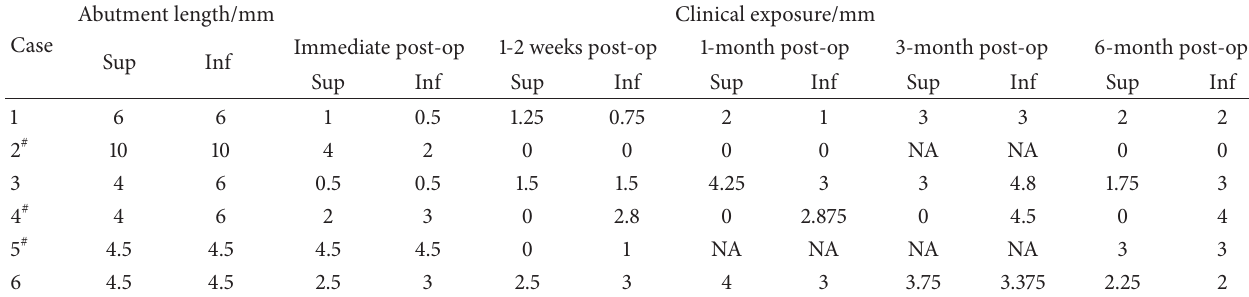
Table 6: Clinical exposure of